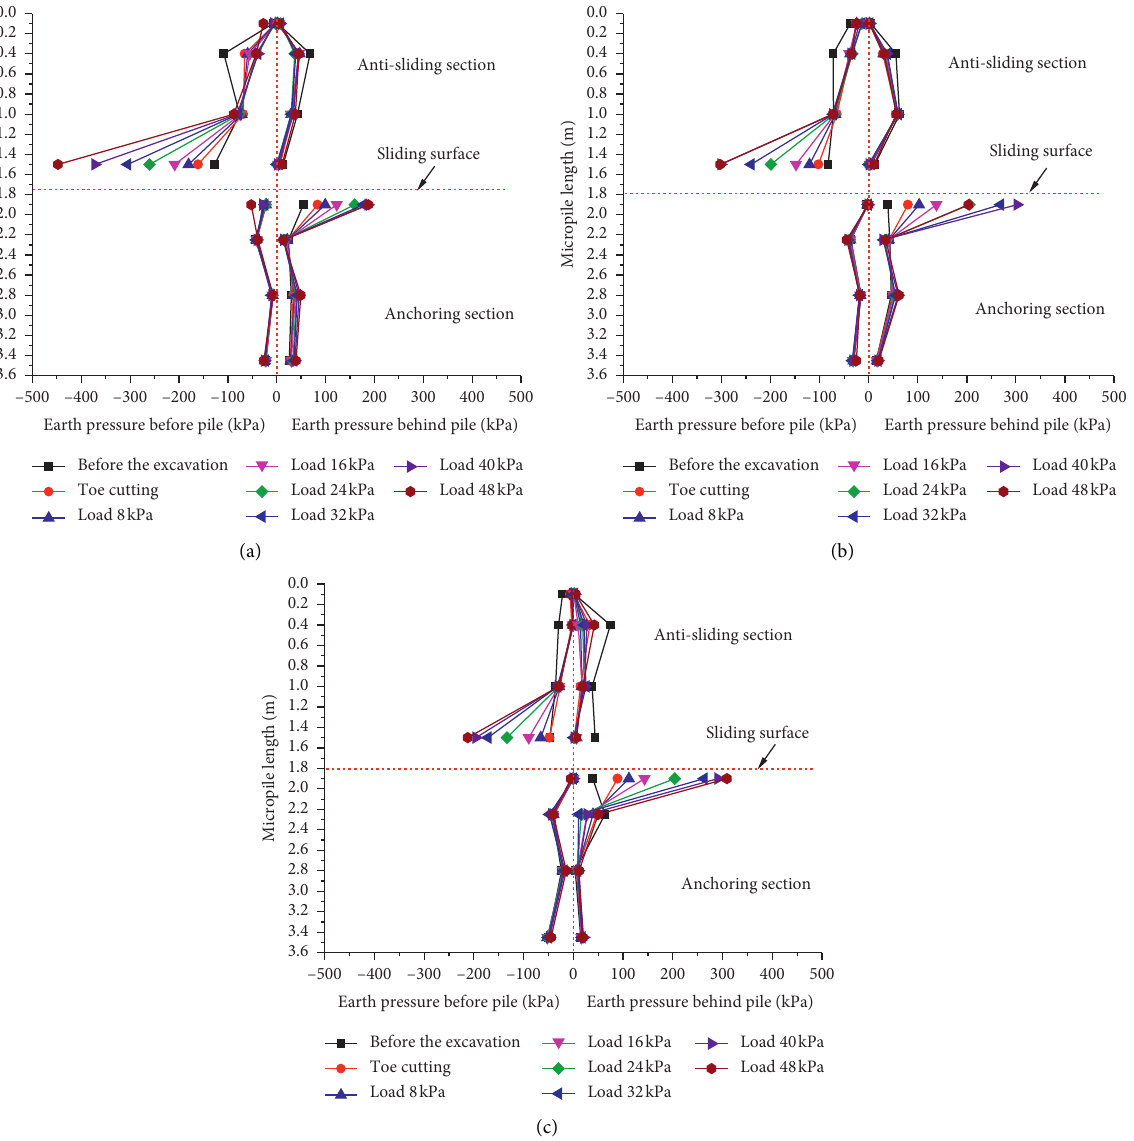
Figure 11: Distribution of the earth pressure on the micropiles. (a) Distribution of the earth pressure on the pile in first row; (b) distribution of the earth pressure on the pile in middle row; (c) distribution of the earth pressure on the pile in last